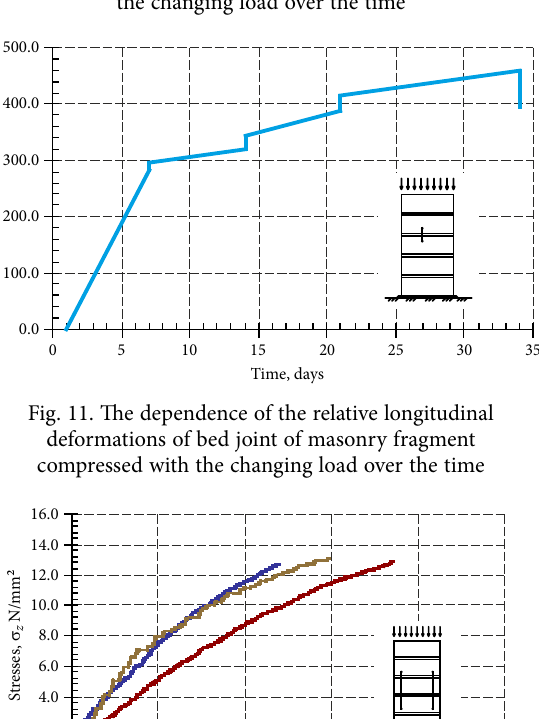
Fig. 8. The relative average shrinkage deformations of masonry mortar in bed joint